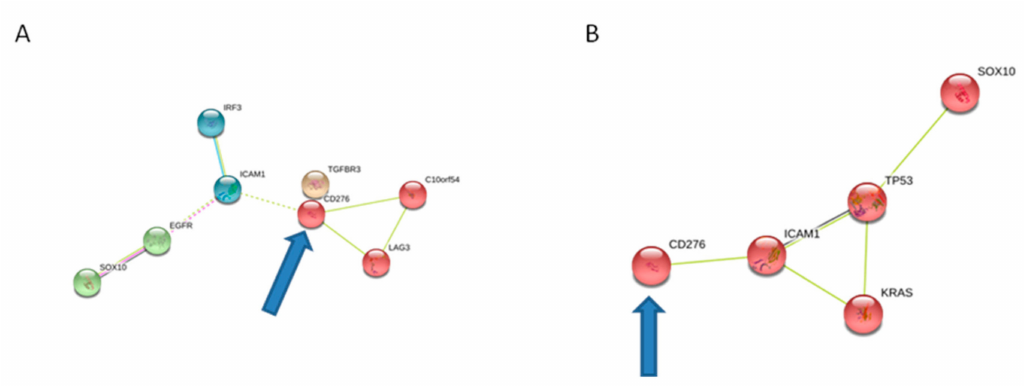
Figure 3. String network including mutated genes in ( A ) lung and ( B ) pancreatic lesion. In the two networks it could be noticed that genes in both of the two pathological settings are connected to CD276, whose mutation is shared by the two